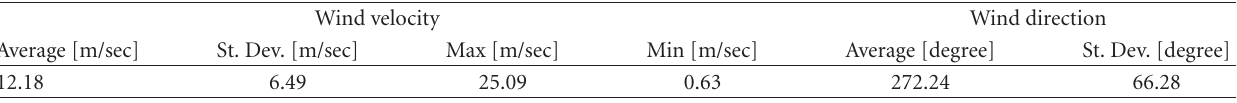
Table 2: Velocity average and standard deviation of the